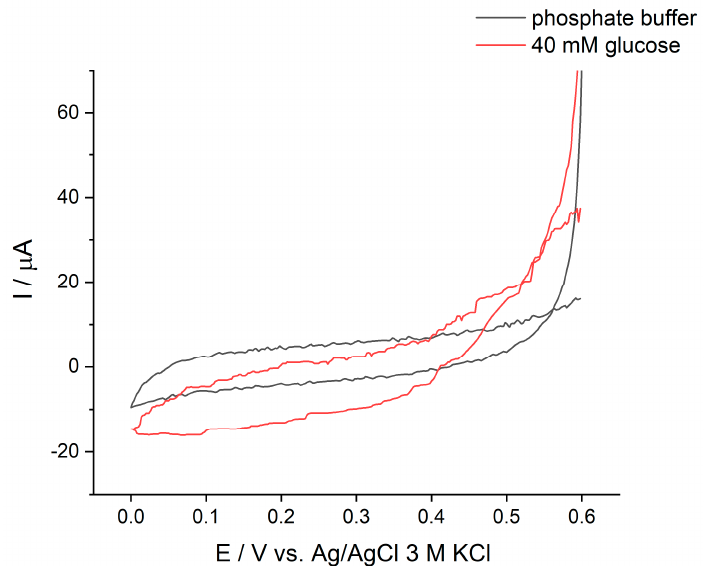
Figure 4. Cyclic voltammograms of the GOx/HRP/MWCNT/GE biocathode in the absence and presence of 40 mM glucose in 0.1 M phosphate buffer pH 7.4 at a scan rate of 1 mV/s, air-saturating conditions.